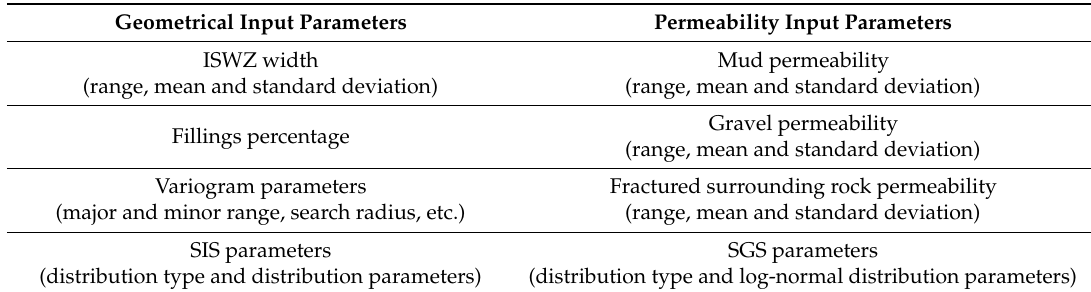
Table 1. Main input parameter groups adopted to generate a numerical model.